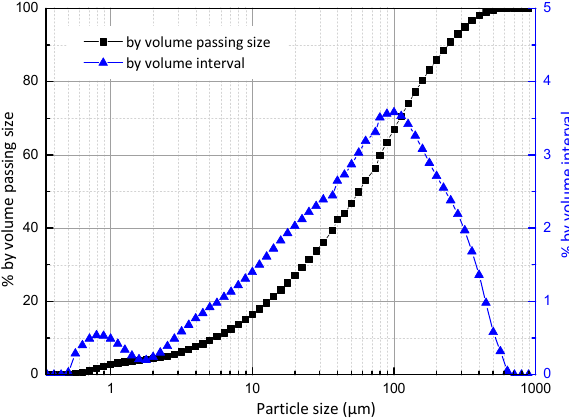
Figure 2. Particle size distribution of tailings.